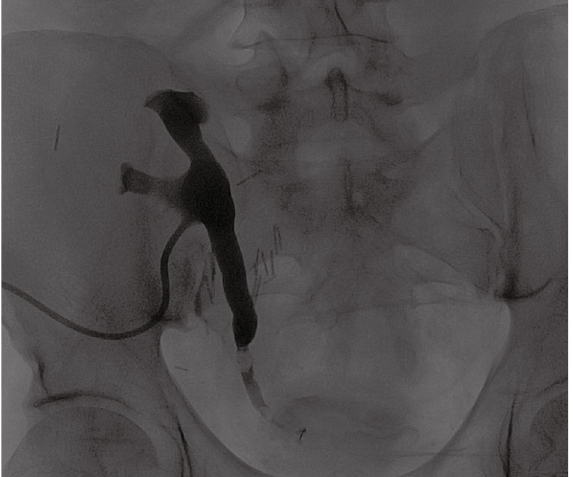
Figure 3: Posttransplant day 44 nephrostogram with mid to distal ureter stricture and clot